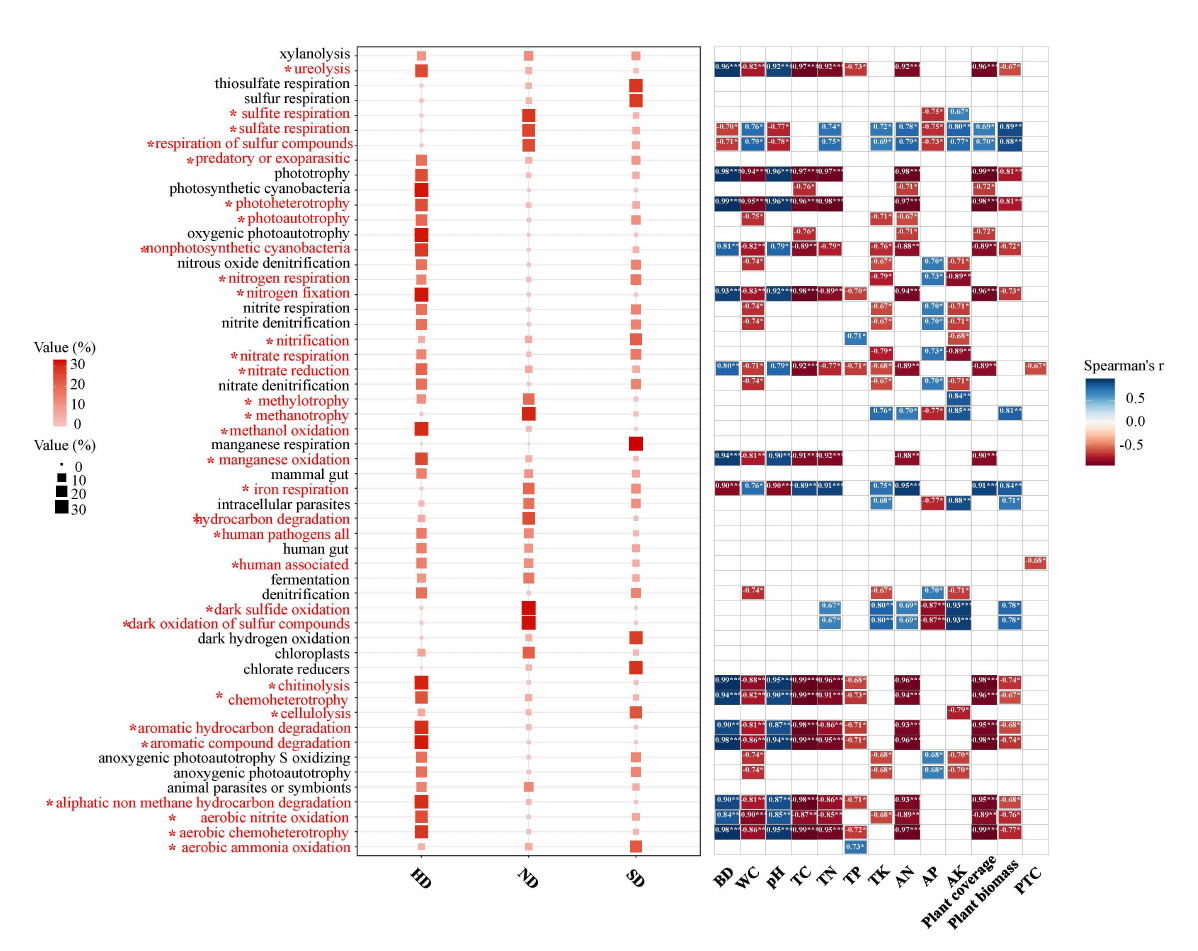
FIGURE 8 Bacterial community functions of the non-degraded (ND), slightly degraded (SD), and heavily degraded (HD) alpine wetland areas. Functional Prediction of Bacterial Communities; Spearman correlation analysis between community function and environmental factors; *: P <0.05; **: P <0.01; *** P